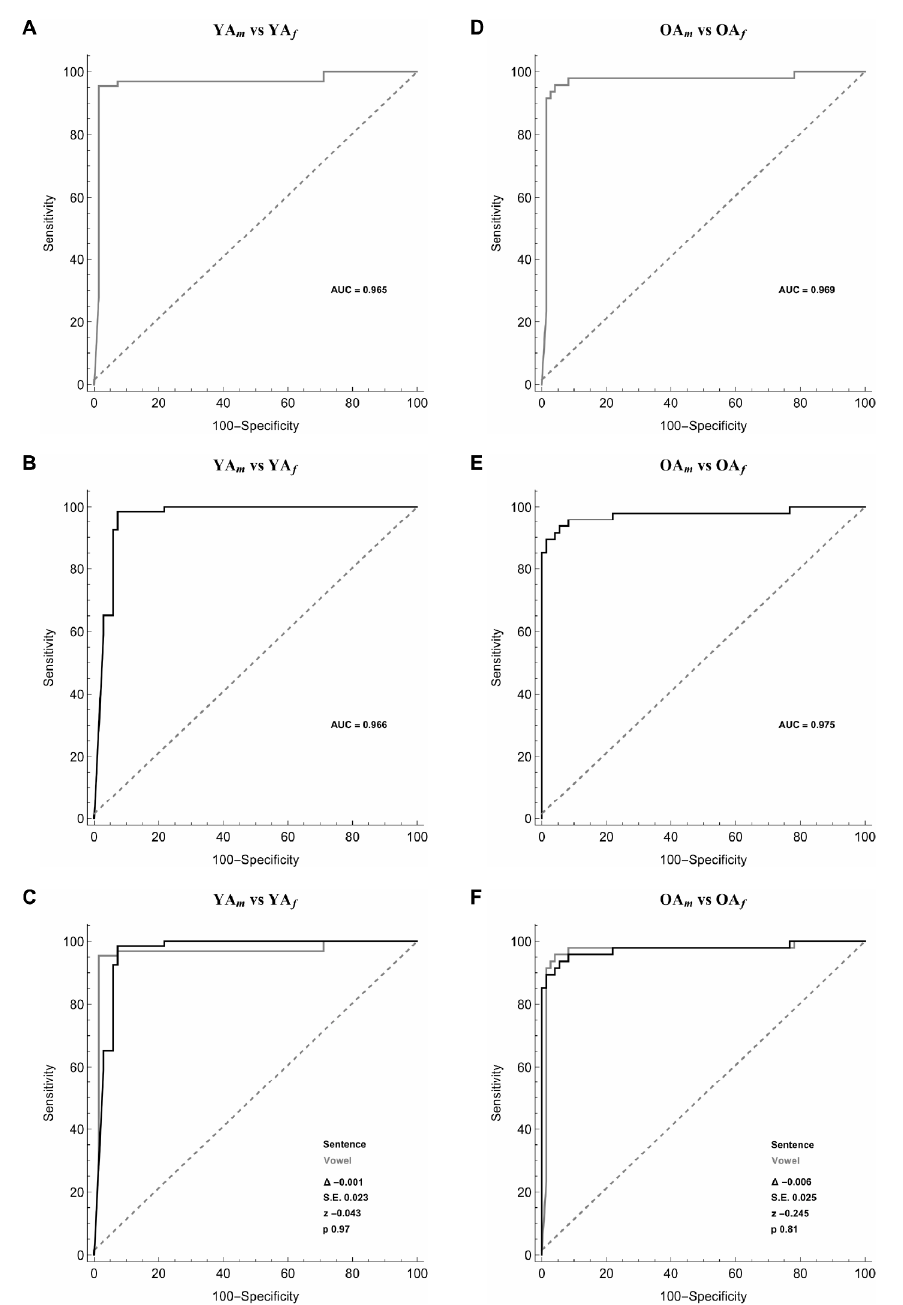
Figure 4. Receiver operating characteristic (ROC) curves used to differentiate female Younger Adults (YA f ) and male Younger Adults (YA m ) (left column, panels ( A – C )) and female older adults (OA f ) and male older adults (OA m ) (right column, panels ( D – F )) during the sustained emission of a vowel (grey line) (panels ( A , D )), the sentence (black line) (panels ( B , E )) and the comparison between the vowel and the sentence (panels ( C , F )).